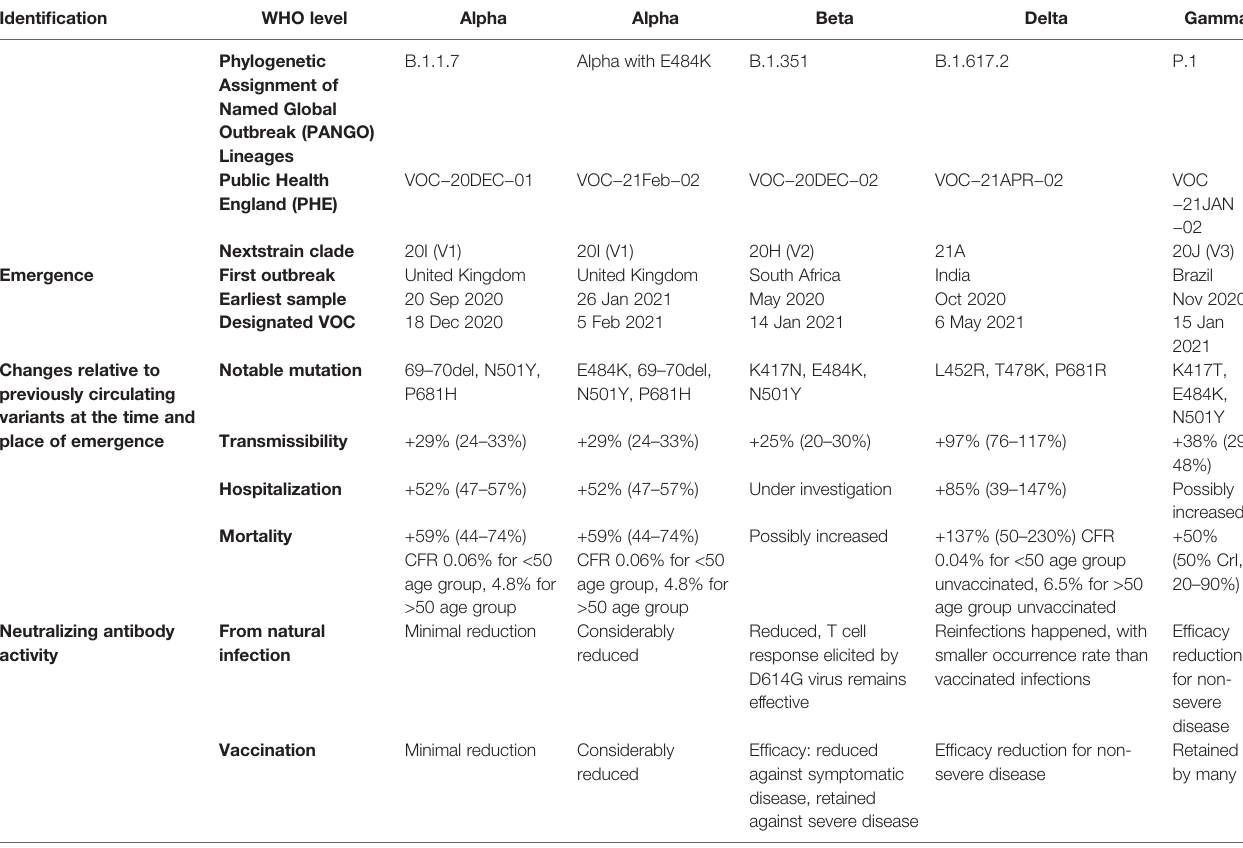
TABLE 2 | Relative risk level for variants of concern